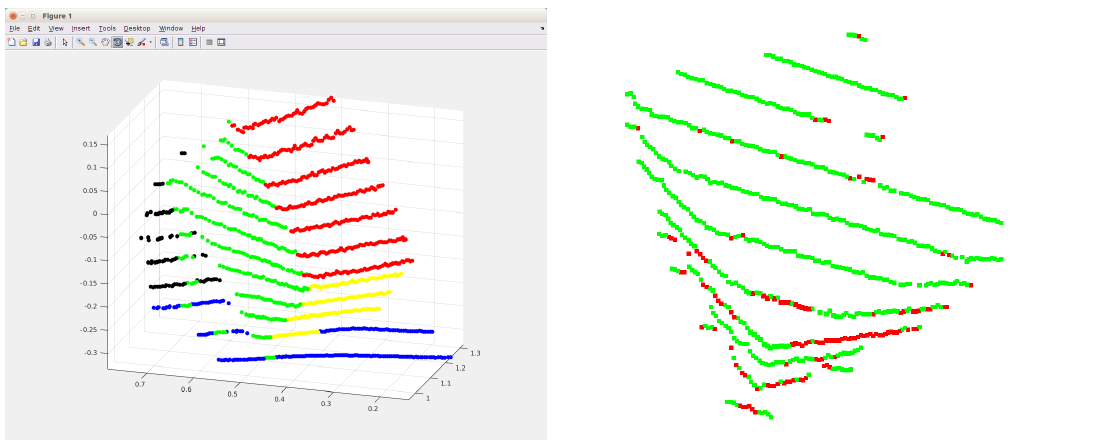
Figure 2. The left image shows the result of the sequential RANSAC. Five different planes are found in this case, each marked by different colors. In the right image, the result of the outlier filtering can be seen. Green and red points indicate inliers and